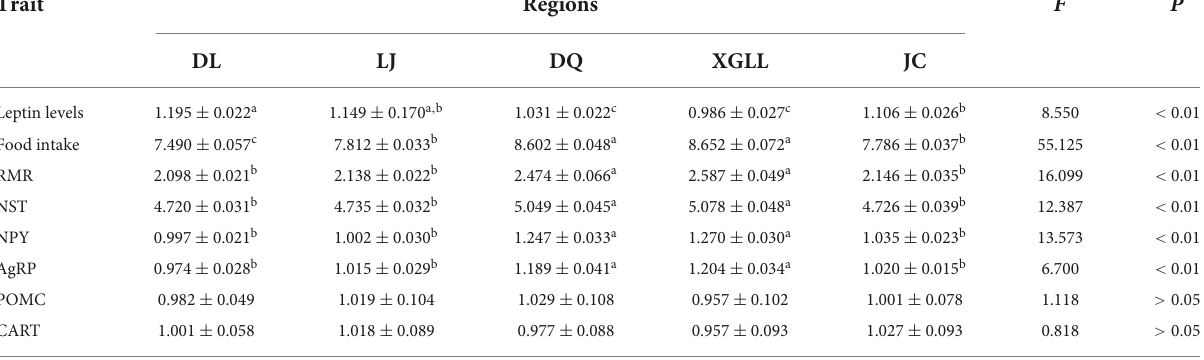
TABLE 3 Comparison of physiological indicators in Eothenomys miletus.